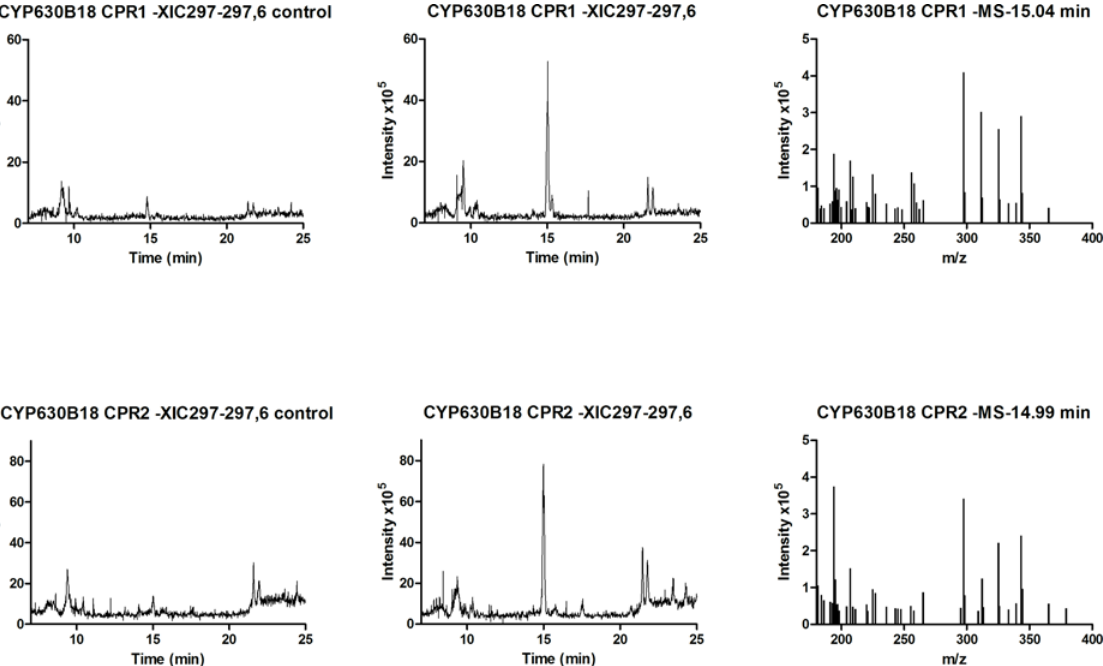
Fig 2. Single extracted ion chromatograms of RS1 and RS2 products. Extracted ion chromatograms (297.2 – 297.6 m/z run in negative-ion ESI) from LC/MS analyses for Gs CYP630B18 activity in RS1 and RS2 with oleic acid as substrate. Empty E . coli membrane fractions were used as control. Mass spectra representing hydroxyoleic acid peaks with RT 15.04 and 14.99 min are shown on the right.